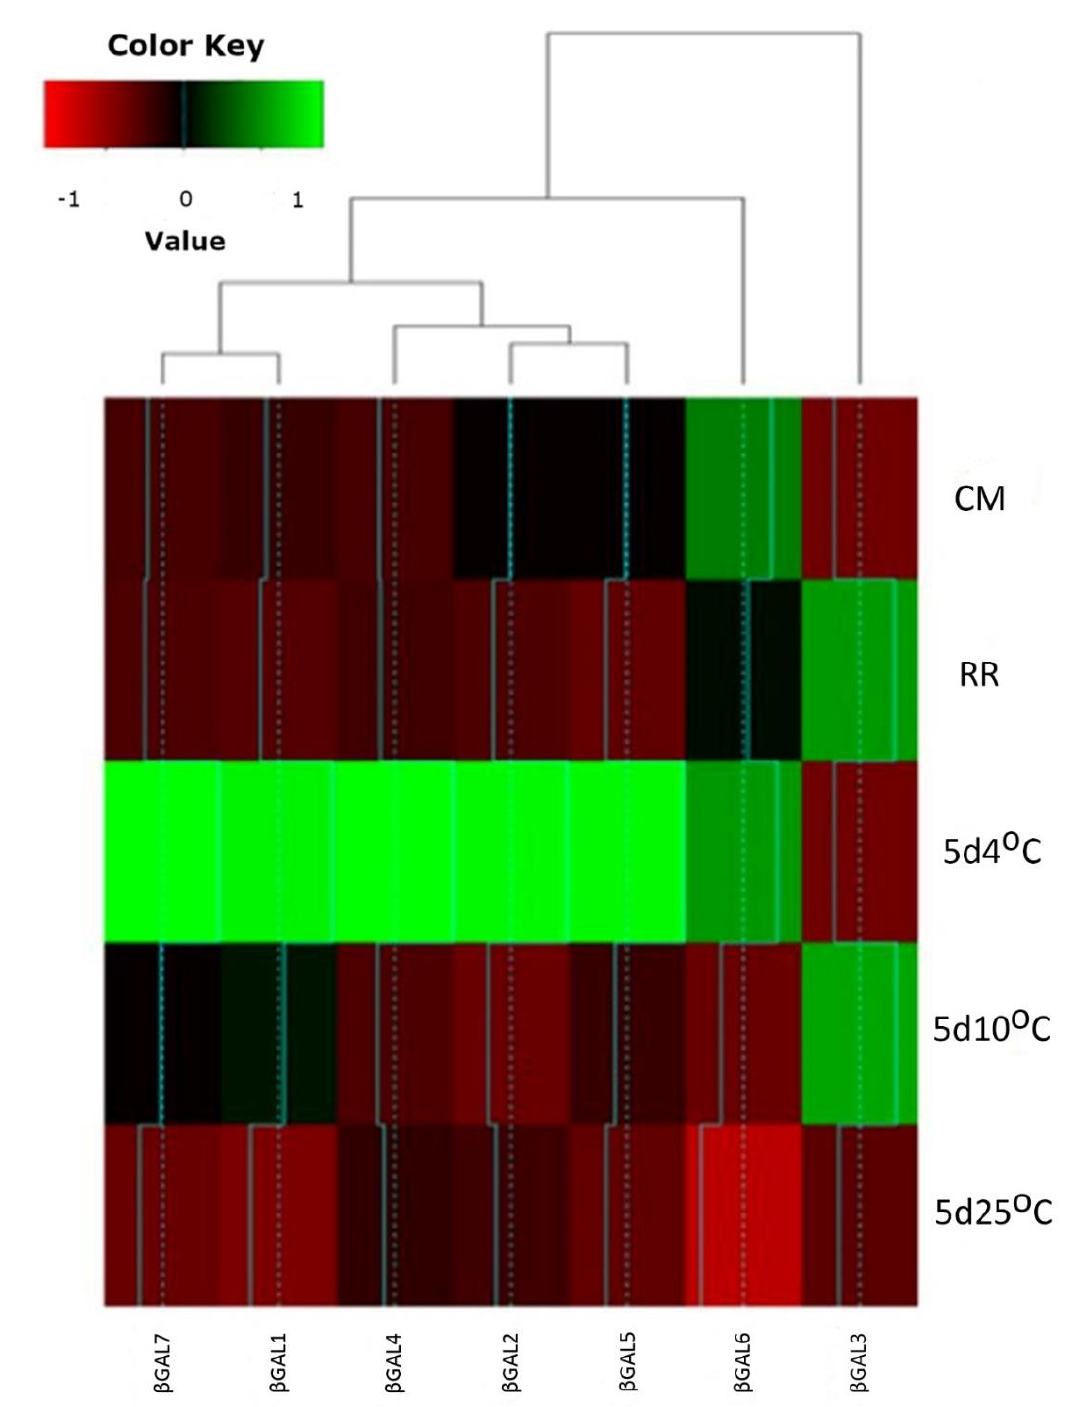
Figure 3 Heatmap of the relative transcription for tomato β -GAL genes (cv. Chondrokatsari) during their late maturation on-plant and after postharvest storage (5 d) at different temperatures (4, 10 and 25 °C). Relative mRNA abundance was assessed by real-time RT-qPCR, employing three independent biological replicates.